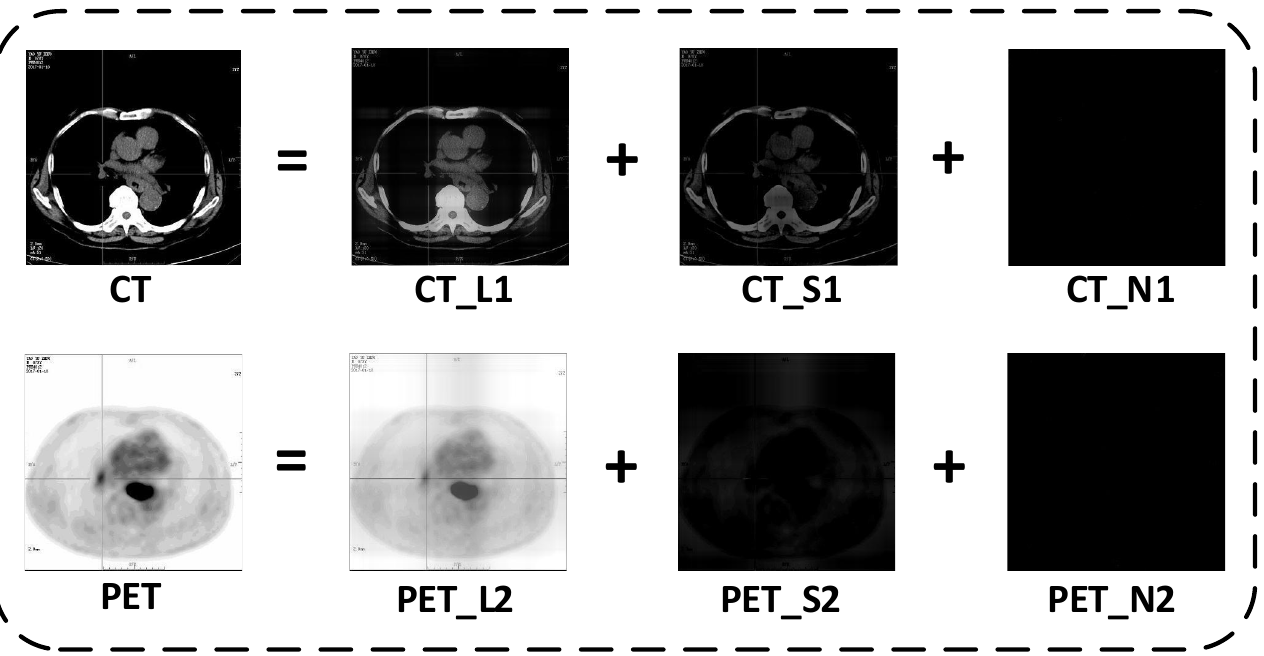
+ and represent the low-rank region im- Figure 2. LatLRR decomposition process. Figure 2. LatLRR decomposition process. CT _ L 1 and PET _ L 2 represent the low-rank region images of the decomposed source images; CT _ S 1 and PET _ S 2 represent the salient region images of the ages of the decomposed source images; and represent the salient region images of 𝐶𝐶𝐶𝐶 _ 𝐿𝐿 1 𝑃𝑃𝑃𝑃𝐶𝐶 _ 𝐿𝐿 2 decomposed source images; and CT _ N 1 and PET _ N 2 represent the noisy region images of the the decomposed source images; and and represent the noisy region images of the decomposed source 𝐶𝐶𝐶𝐶 _ 𝑆𝑆 1 𝑃𝑃𝑃𝑃𝐶𝐶 _ 𝑆𝑆 2 decomposed source images. 𝐶𝐶𝐶𝐶 _ 𝑁𝑁 1 𝑃𝑃𝑃𝑃𝐶𝐶 _ 𝑁𝑁 2